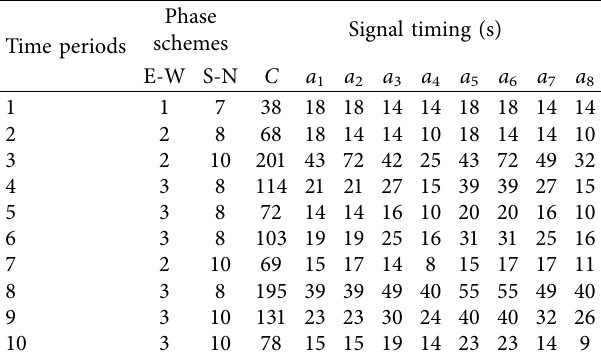
Table 5: Phase timing results of time periods of scheme C. Time periods